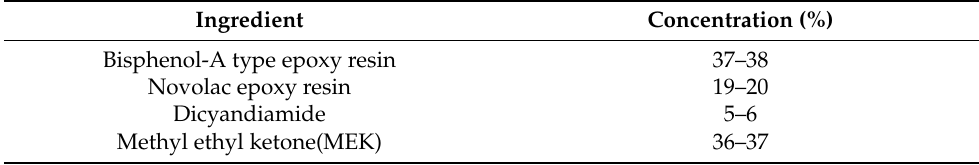
Figure 1. Geometric dimensions and the surface texture of CFRP specimen (unit: mm). ( a ) Geometric dimensions of CFRP specimen; ( b ) photograph of test region; ( c ) an enlarged view of the selected area of ( b ) taken by optical microscope. Table 1. Chemical composition of epoxy in